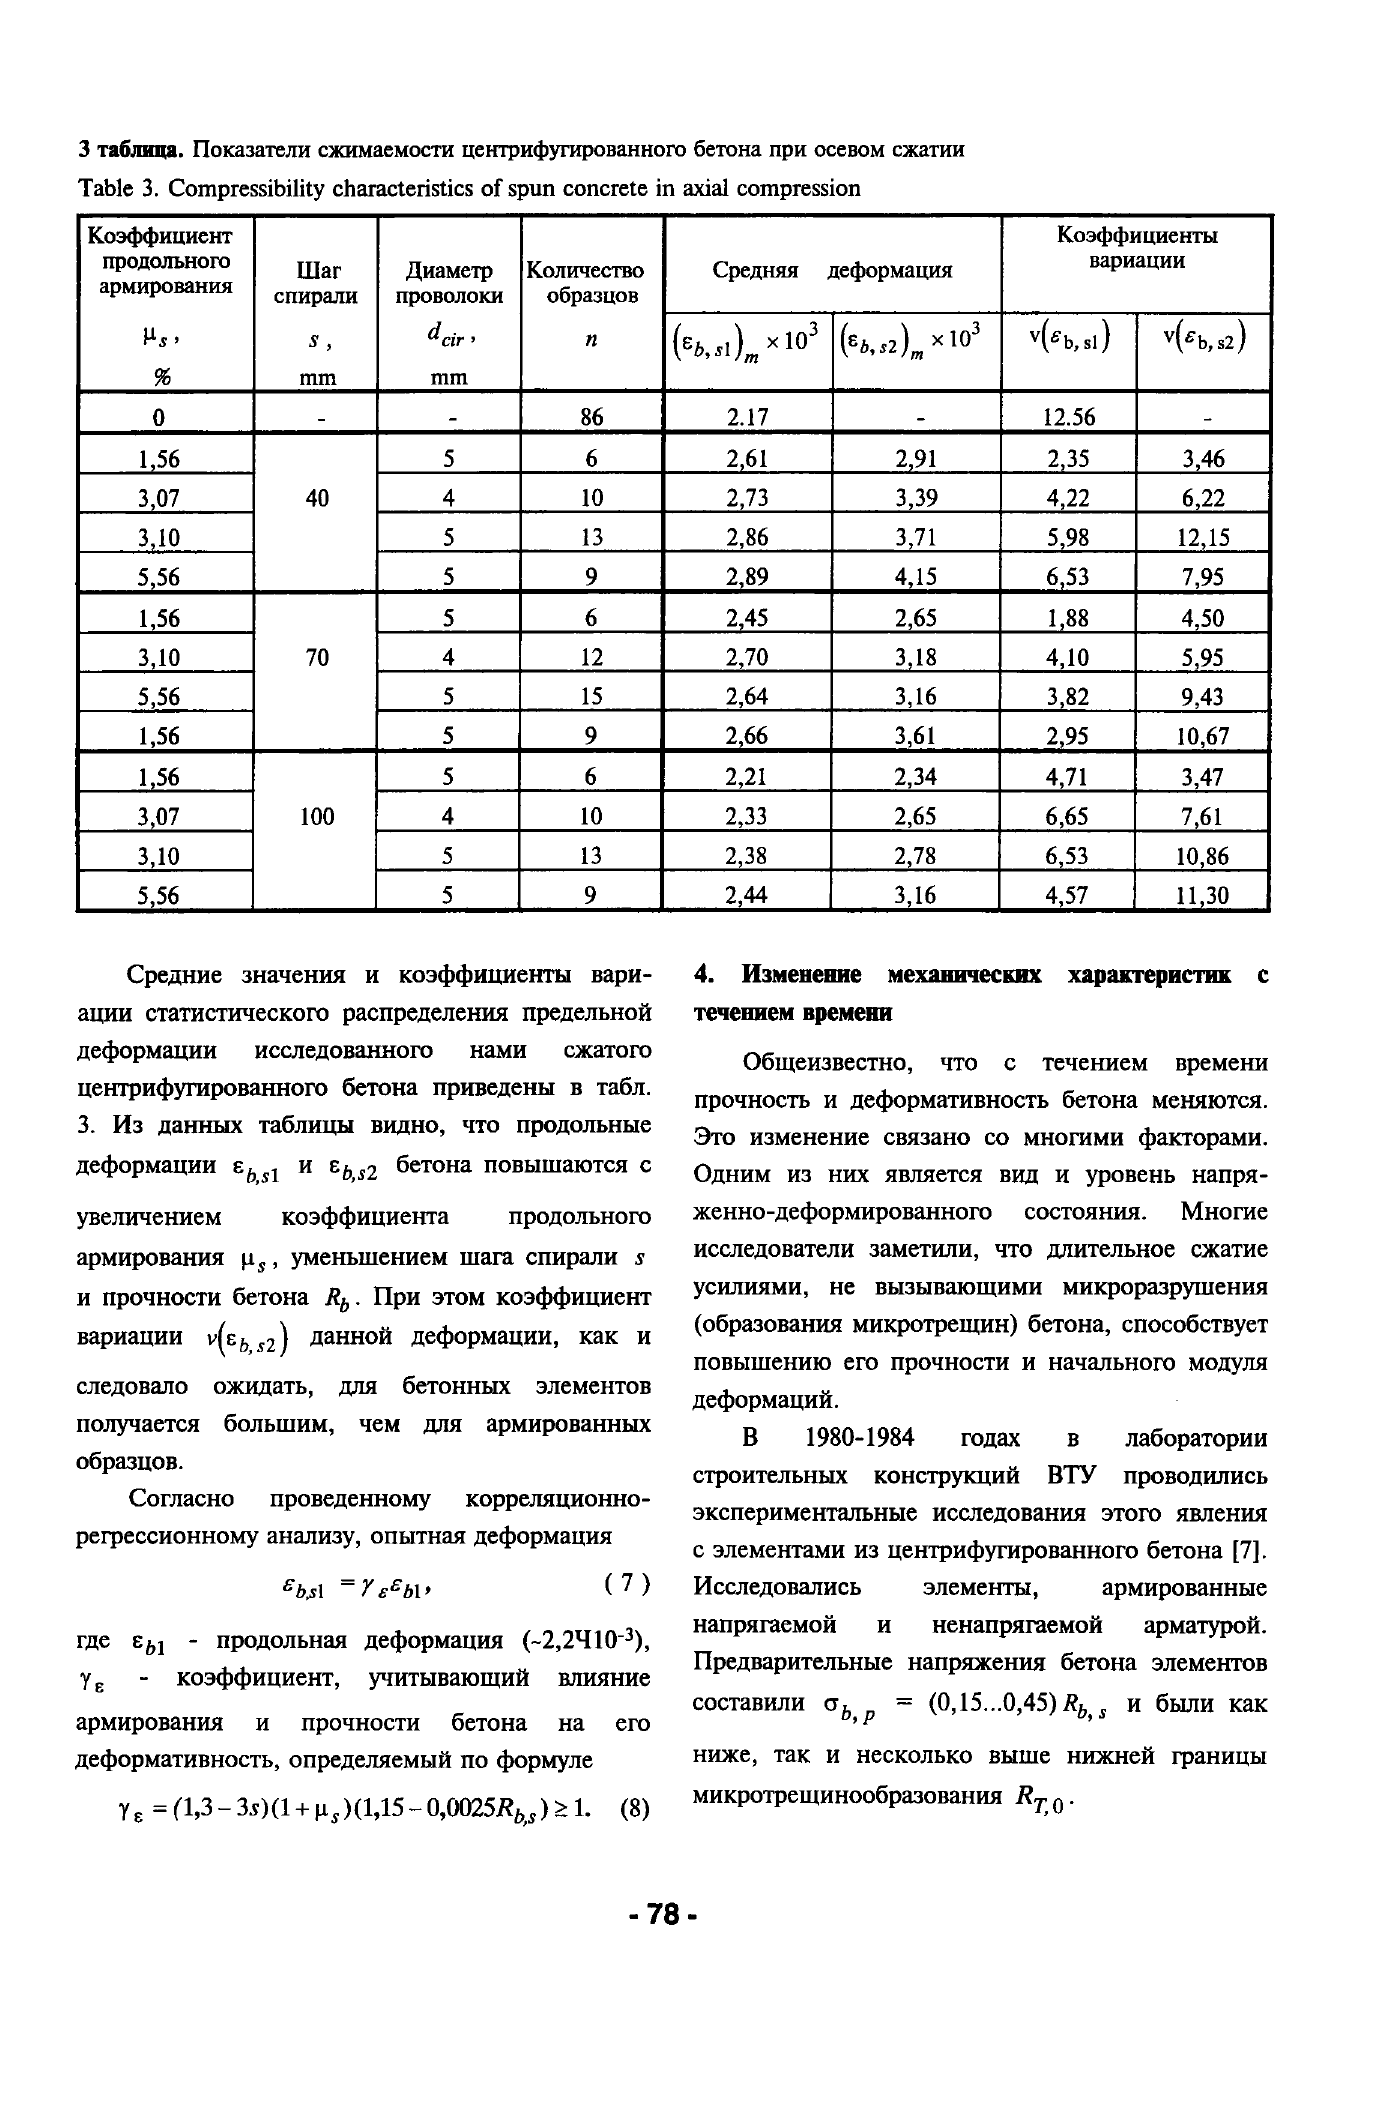
Table 3. Compressibility characteristics of spun concrete in axial compression Ko3clJcpHn:HeHT